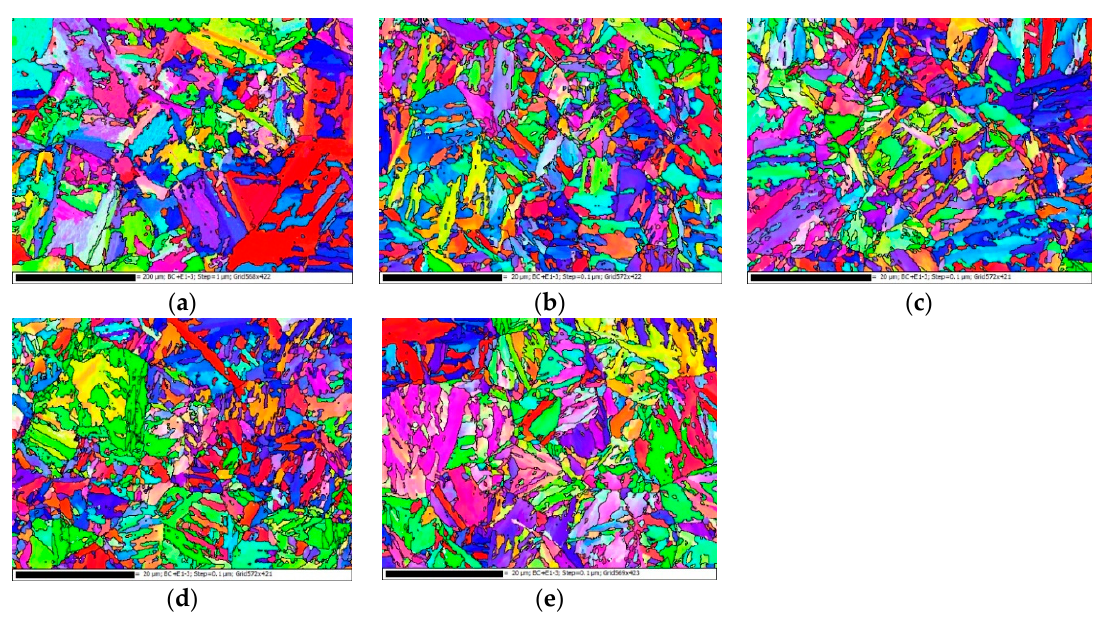
Figure 10. The orientation maps for ( a ) BM, ( b ) HD-L, ( c ) HD-T, ( d ) CF-L, and ( e ) CF-T.